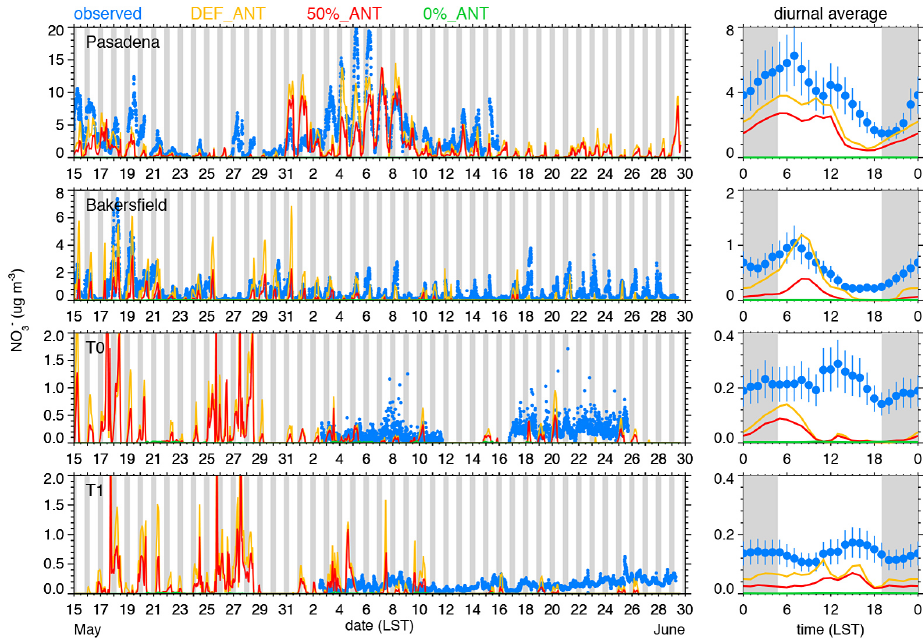
Figure 18. Observed and simulated time series (left panels) and average diurnal variation (right panels) of NO − Simulated NO − is the total of the first four model size bins up to 0.625µm diameter. Gray shading denotes night and vertical lines in right 3 panels denote measurement uncertainty range. Results from 50%_LBC simulation not shown since it is nearly the same as the 50%_ANT simulation.